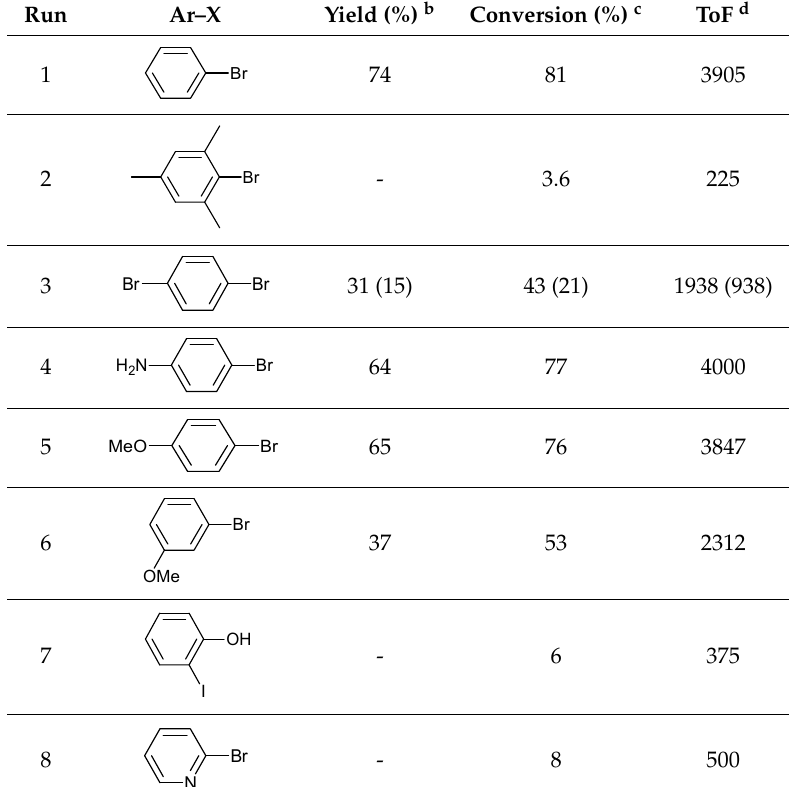
efficiency abruptly dropped in the case of 2,4,6-trimethylbromobenzene (Run 2, Table 4), being attributed to the steric crowding of both ortho -methyl substituents. Table 4. Heck reaction of various aryl bromides and styrene using complex Pd5 a . Run